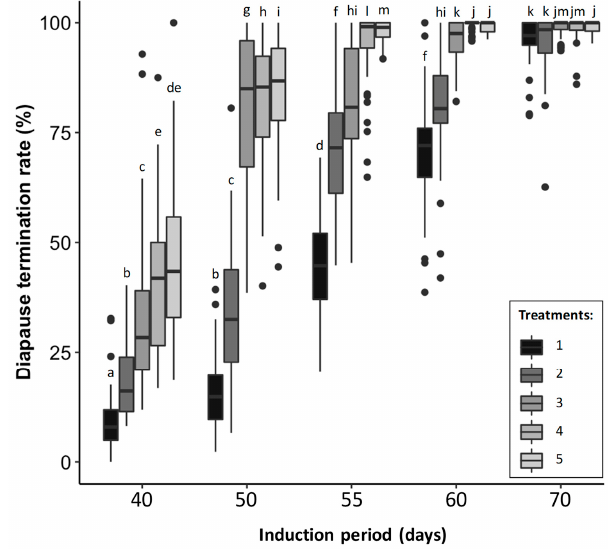
Figure 1. Diapause termination rate (%) in T. dendrolimi depending on the group (diapause induc- tion at 3 °C for 40, 50, 55, 60, or 70 days) and the treatments described in Table 1. Different lower- case letters on top of the boxplots indicated a significant difference among conditions (each treat- ment belonging to each group) ( p < 0.05). The black circles represent the outliners and what the letters represent is described in the legend. Different letters indicate a statistical difference for each condition with the others (GLMM following a binomial distribution).